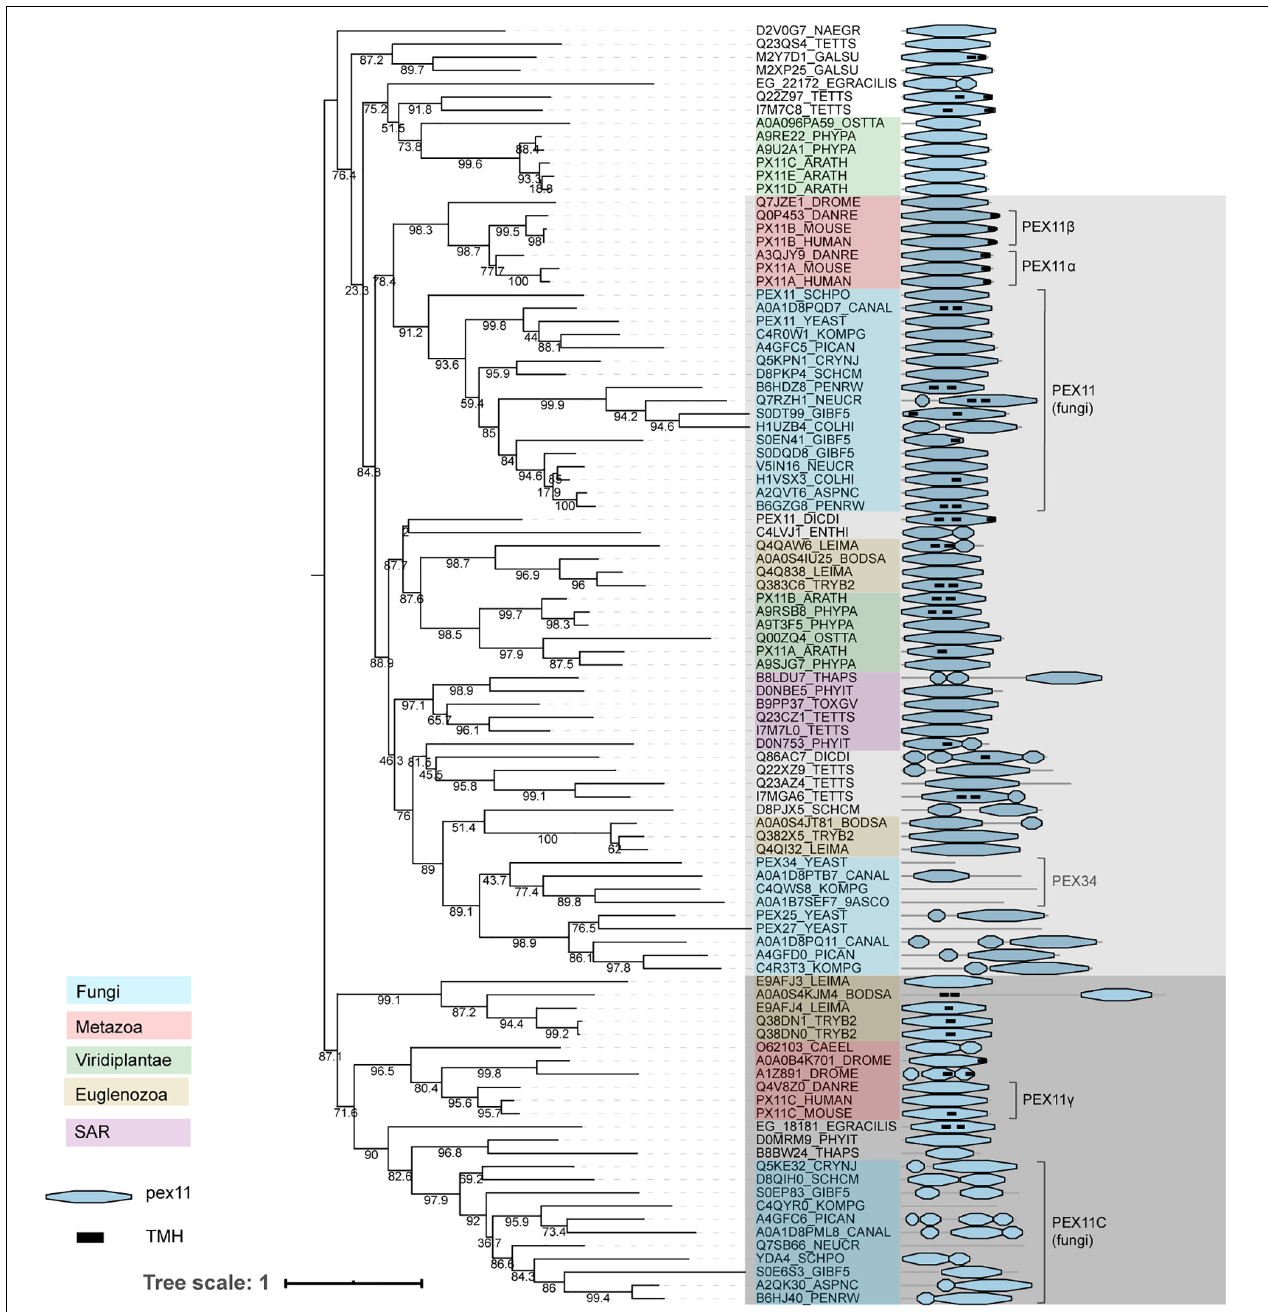
FIGURE 6 | Phylogeny and protein features of PEX11 family proteins. The phylogeny is rooted at mid-point to ease the visualization and labels of the main taxonomic groups are colored accordingly to the legend. Note that the topology does not necessarily reflect the actual evolutionary trajectory of such proteins. Protein domain architecture is defined by pfam annotations and transmembrane helix prediction (black box). The two main groups, shaded light and dark gray, are distinguished according to the most supported and basal bootstraps and their taxonomic